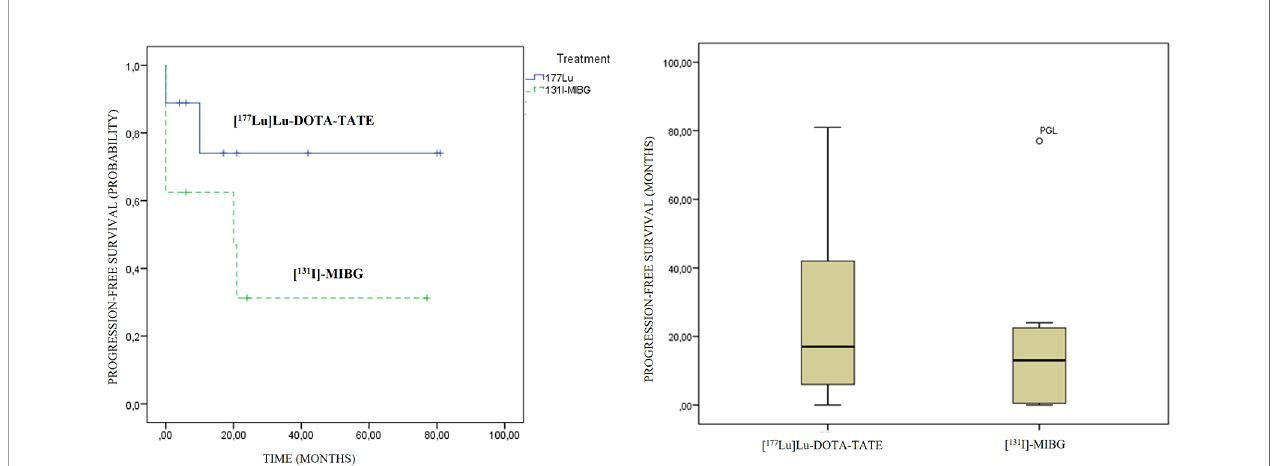
FIGURE 6 | [ 177 Lu]Lu-DOTA-TATE and [ 131 I]MIBG progression-free survival graphics. On the left side, Kaplan – Meier curves; and on the right side, box plots are